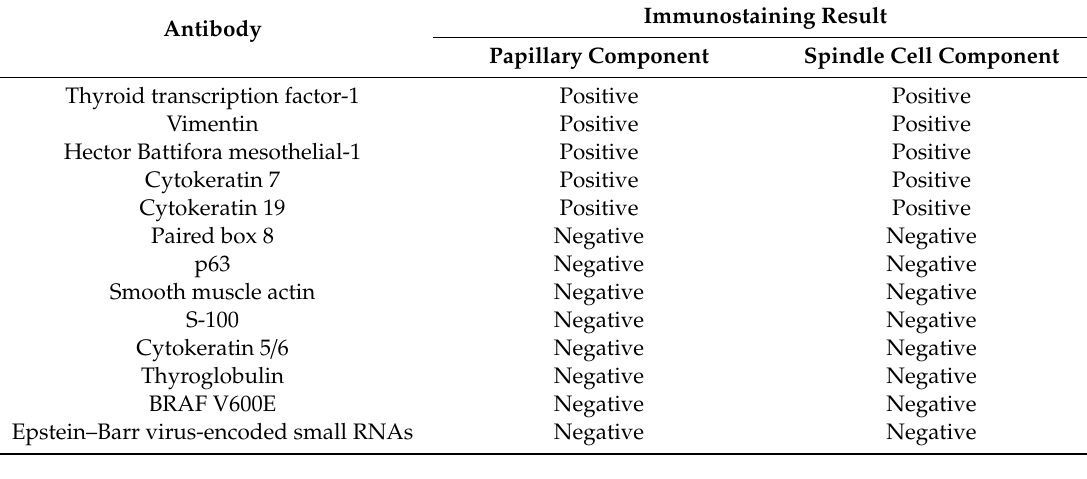
Table 1. Immunostaining results in the papillary and spindle cell components of biphasic thyroid-like low-grade nasopharyngeal papillary adenocarcinoma.